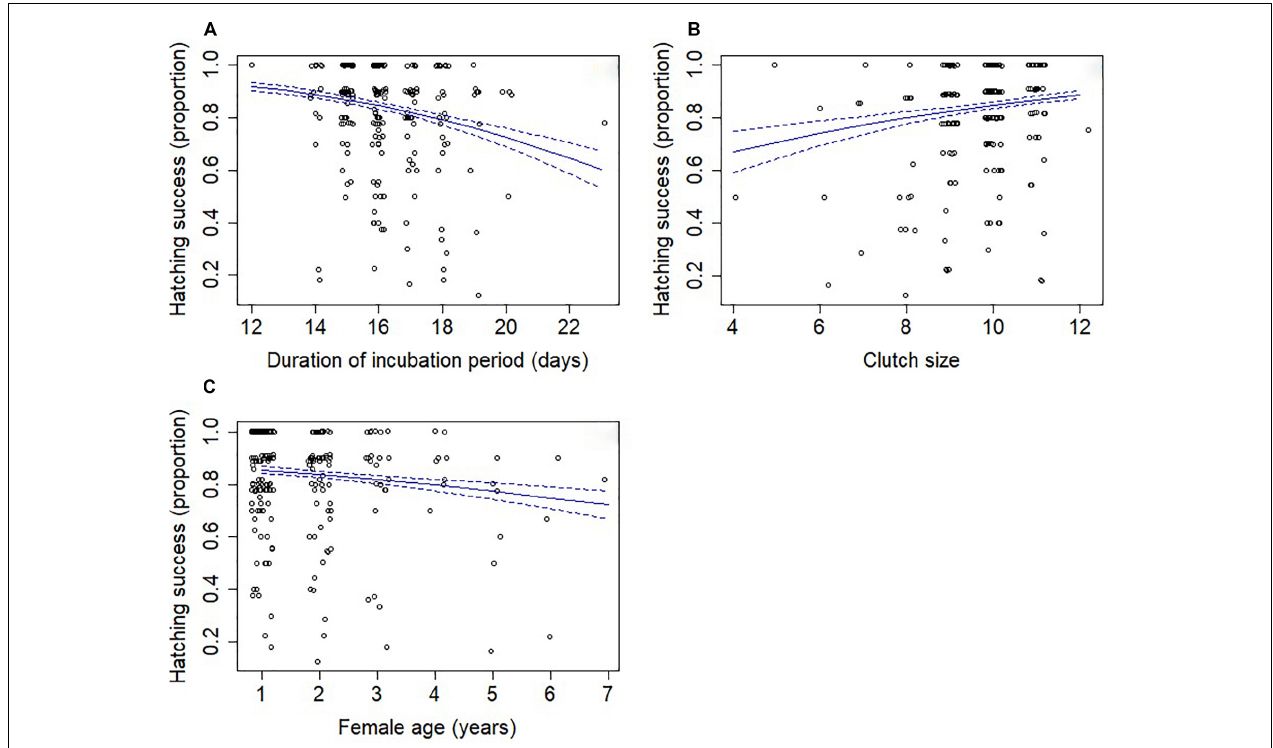
FIGURE 2 | Hatching success (proportion) in relation to (A) the length of the incubation period, (B) clutch size and (C) female age. Points have been offset so that overlapping points can be better seen. The solid lines indicate the predicted values from model-averaged parameters and dashed lines indicate the standard